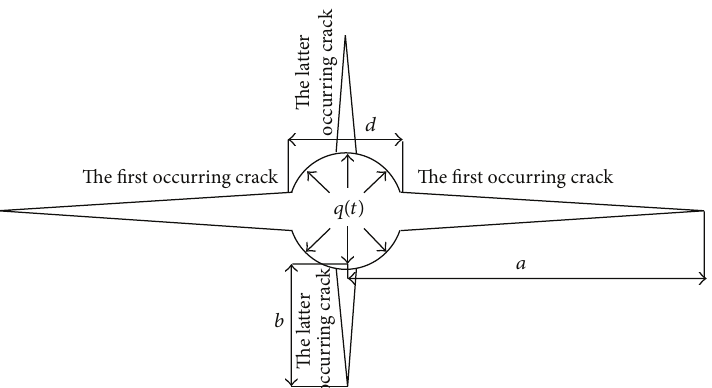
Figure 11: The crack expansion